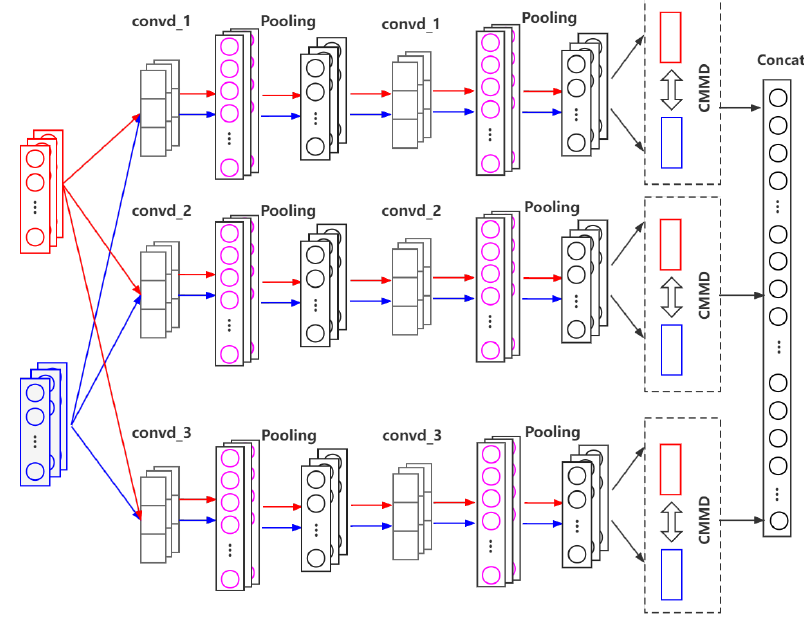
Figure 7. MRAN network